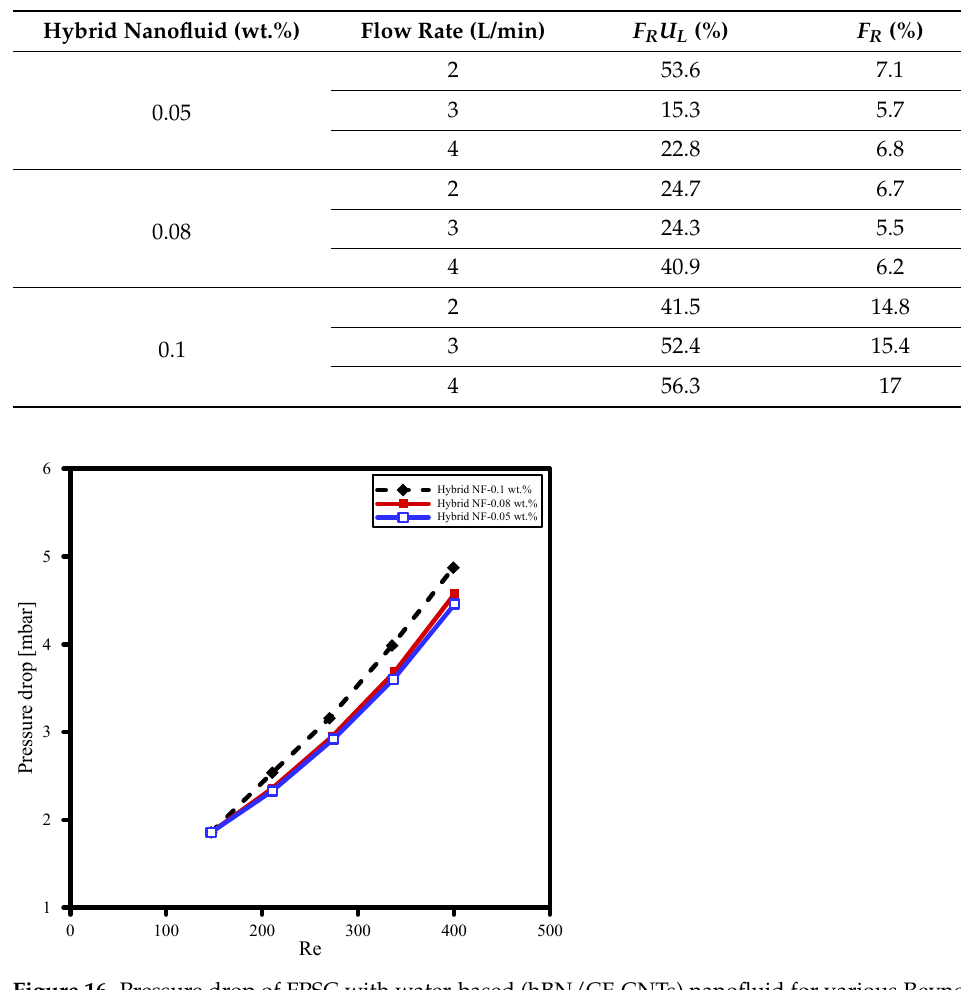
Figure 17. Pumping power of FPSC with water-based (hBN/CF-CNTs) nanofluid for various Reyn- olds numbers at 960 W/m 2 and 30 °C.